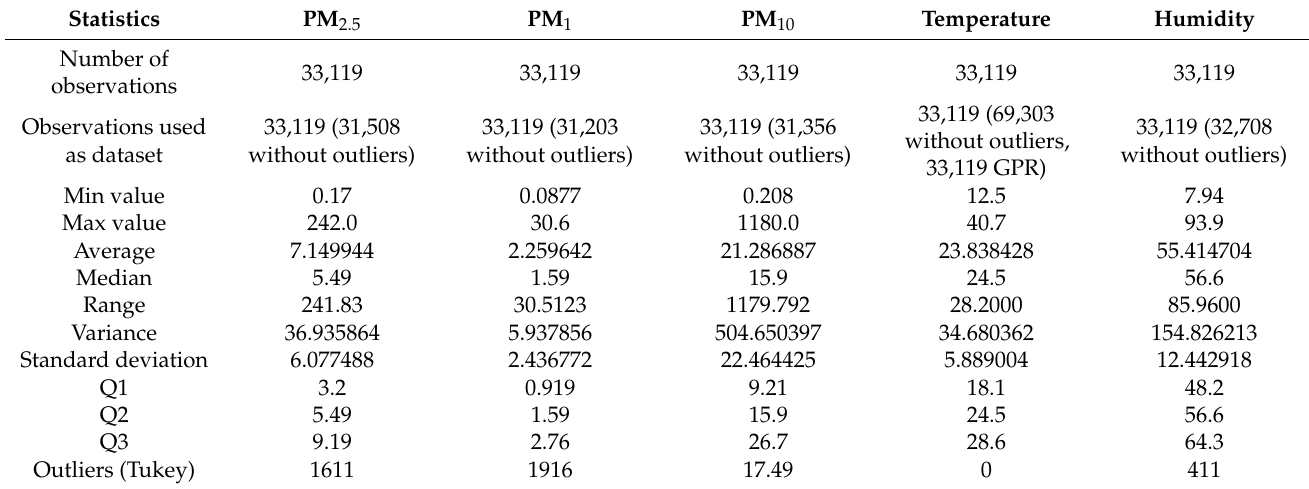
Table 4. Statistical details of the data for the particulate matter measuring